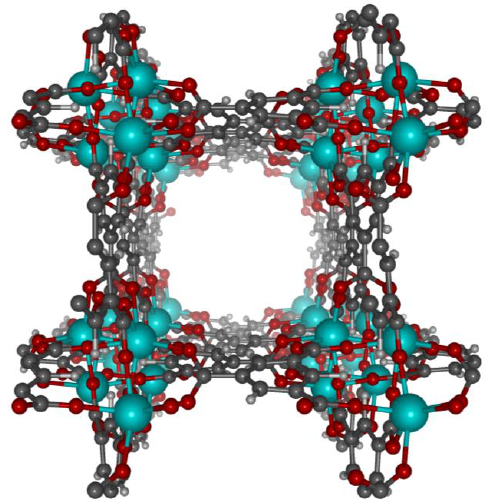
Figure 1. The square channel of Y(btc) viewed along the c axis (vanishing perspective is used). Shown are Y (light blue), C (dark grey), O (red) and H (light grey).